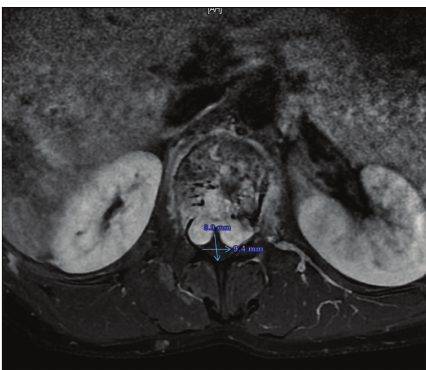
Figure 1: A burst fracture of L1 associated with a vertebral heman- gioma causing canal compression with expansion of the L1 body.